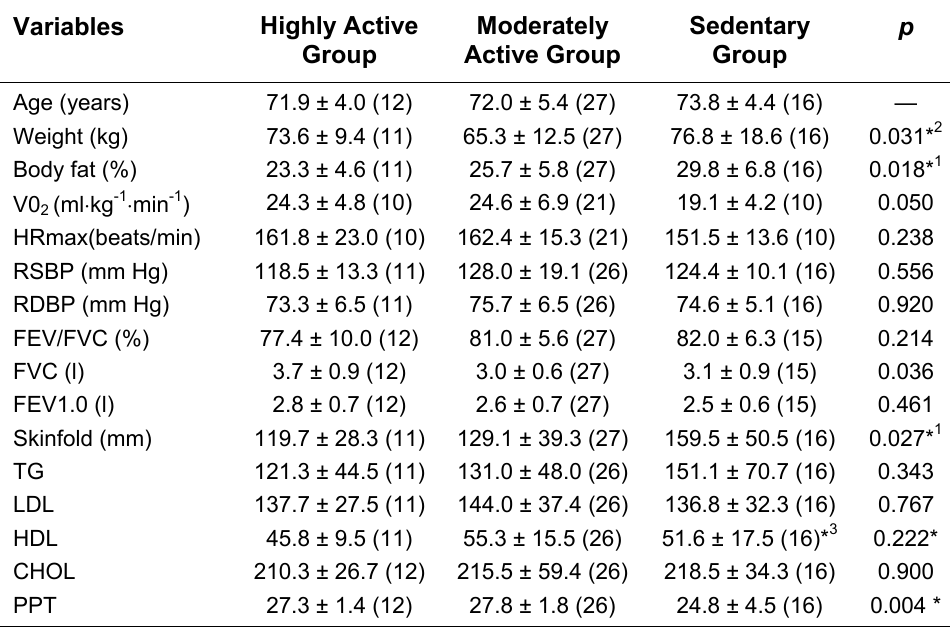
Cross-Sectional Comparison for Current